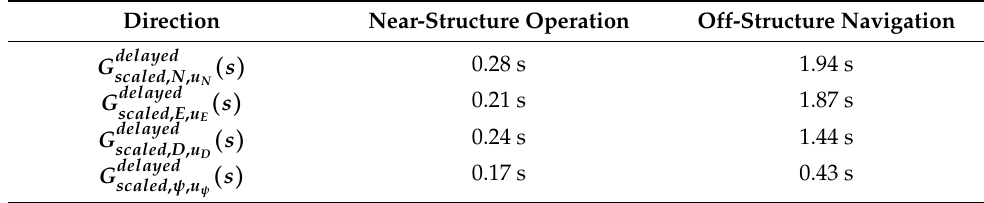
Table 8. Maximum time delay for stable nominal closed-loop system. Direction Near-Structure Operation Off-Structure